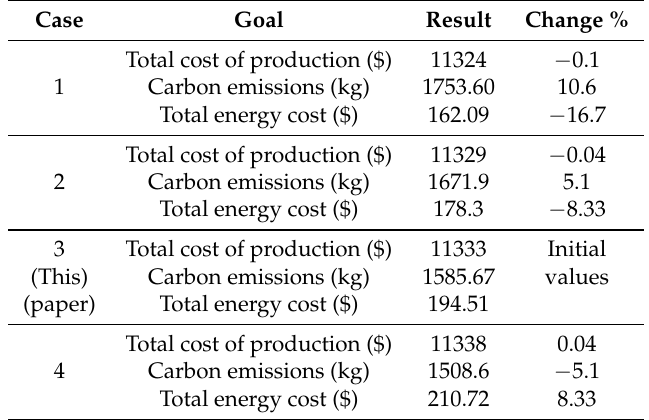
Table 12. Percent change observed in the objectives of the model with variations of solar energy